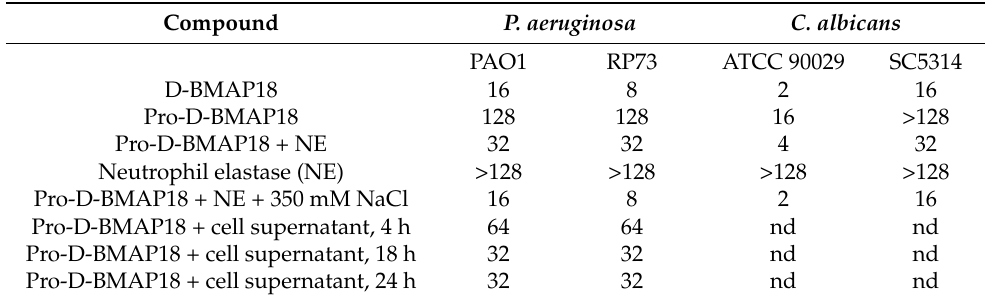
Table 2. MIC values ( µ g/mL) of D-BMAP18 and of D-BMAP18 released from Pro-D-BMAP18 incubated with elastase or elastase-containing conditioned cell medium.